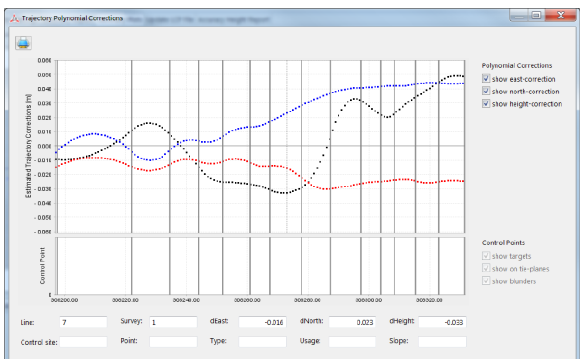
Figure 4. Trajectory polynomial corrections ensuring smooth transition